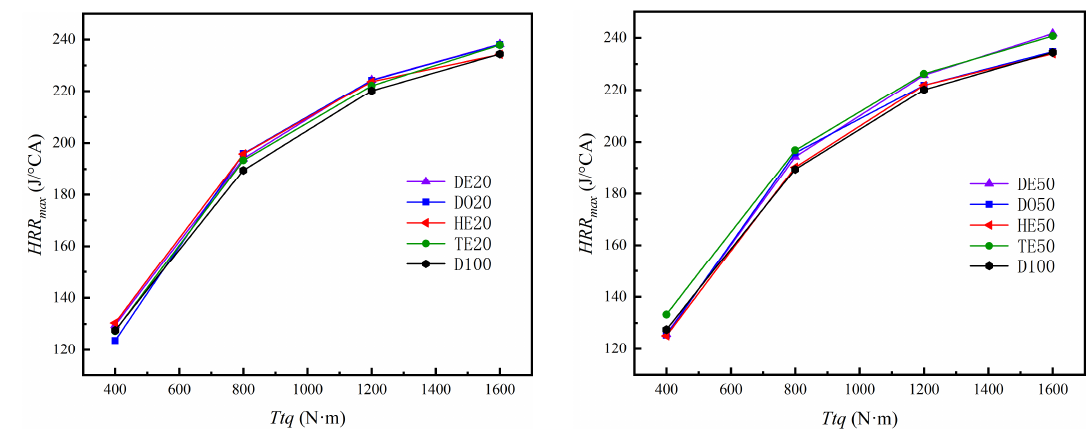
Figure 10. The peak values of HRR versus engine loads.